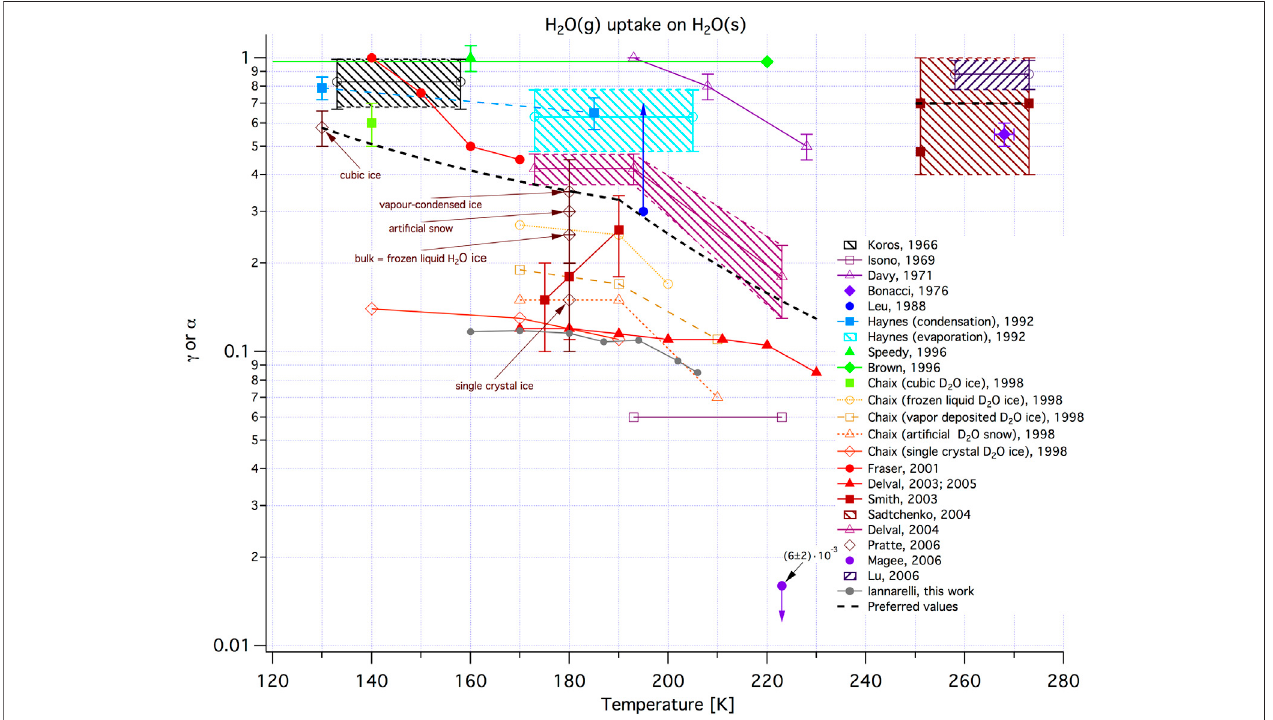
FIGURE11| Synopsisoftheuptake( γ )and/ormassaccommodationcoef fi cients( α )forH 2 O(D 2 O)vaporonH 2 Oice.NodataonsupercooledH 2 Oassubstrateare included (taken from PhD thesis of R. Iannarelli, accepted by ETHZ in 2014 as thesis no. 21791. In the legend the corresponding referred publication is Iannarelli and Rossi,